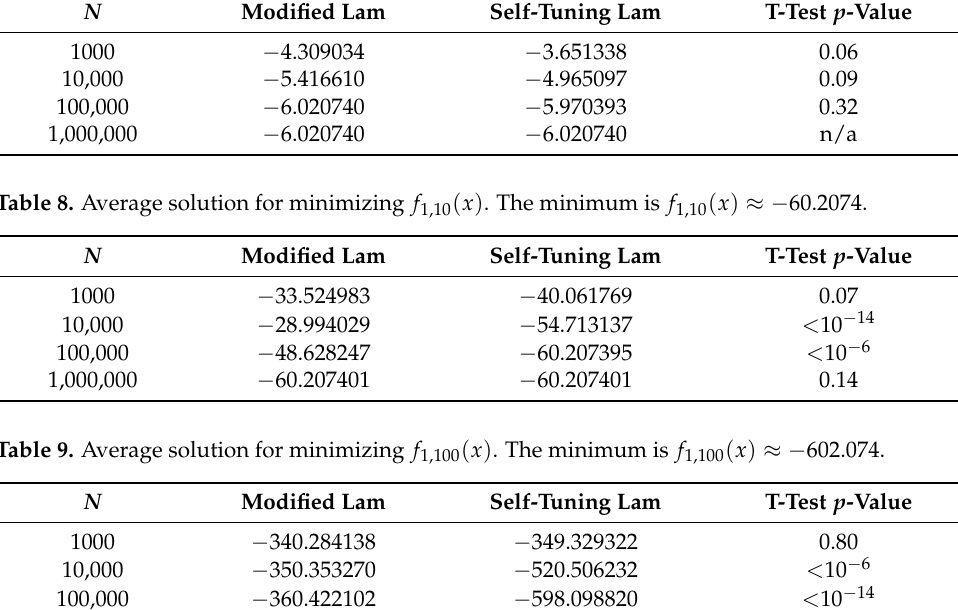
Table 7. Average solution for minimizing f 1,1 ( x ) . The minimum is f 1,1 ( x ) ≈ − 6.02074. N